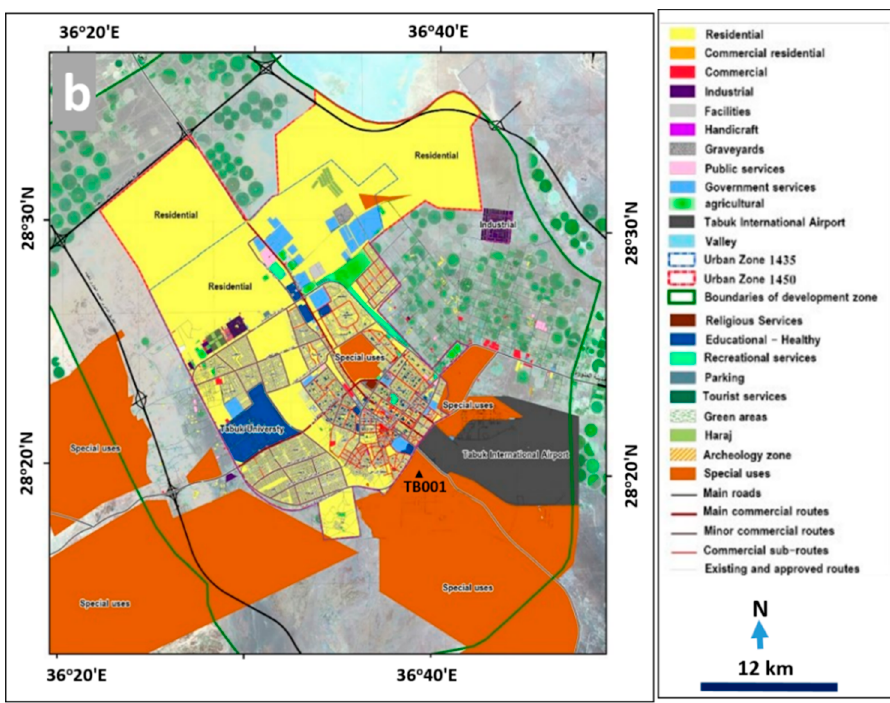
Figure 1. ( a ) Location of Tabuk City in the Kingdom of Saudi Arabia (KSA); ( b ) neighborhoods of Tabuk City, showing its planned urban expansion until 2030. (Source: Ministry of Municipal and Rural Affairs, Cities Planning Agency, General Administration for Urban Planning, Atlas of City Expansions, Tabuk City, No. 21356.).